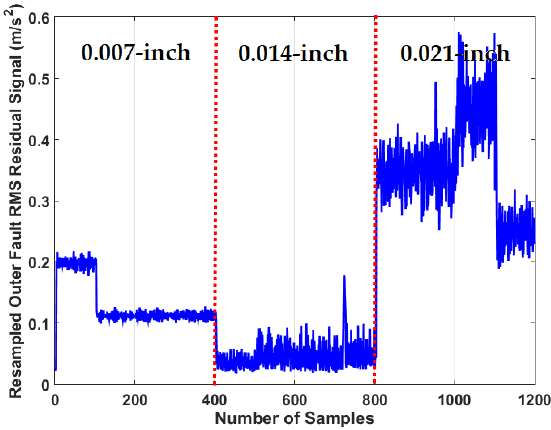
Figure 14. The RMS resampled inner fault residual signal using the proposed ADT algorithm for crack size identification.